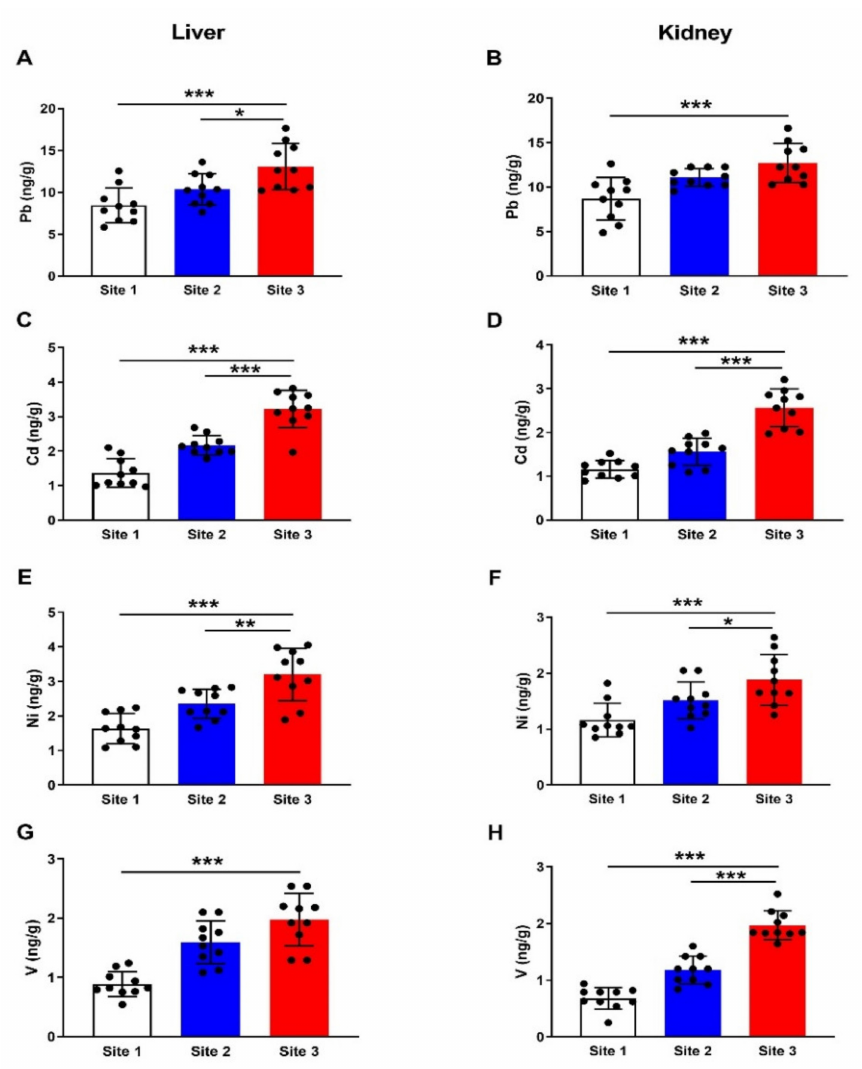
Figure 4. Concentrations of Pb ( A , B ), Cd ( C , D ), Ni ( E , F ), and V ( G , H ) in liver and kidney of camels at the studied sites. Data are mean ± SD ( n = 10). * p < 0.05, ** p < 0.01 and *** p <